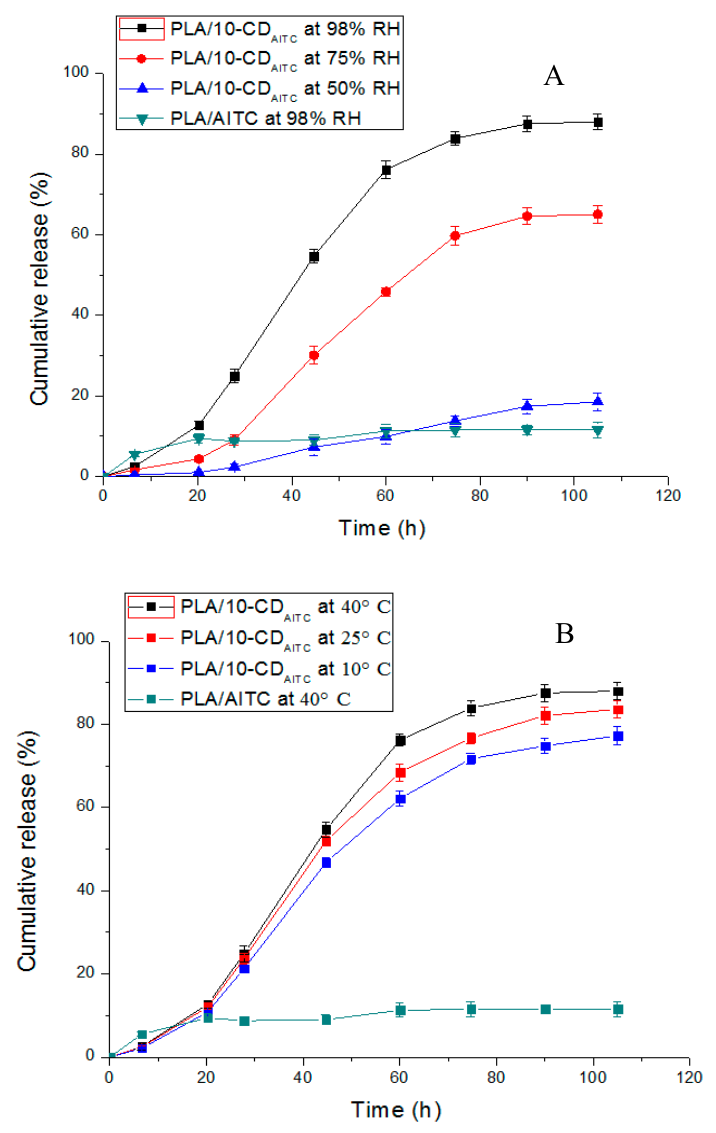
Figure 5. Release behavior of AITC from AITC/PLA and β -CD/AITC/PLA films, respectively, at different relative humidity (RH) (( A ), at 40 °C) and temperature (( B ), at 98% RH).